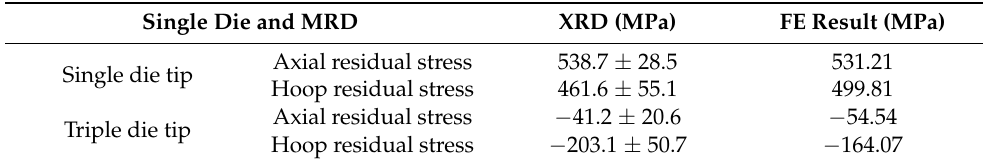
Table 7. Comparison of the measured and predicted residual stresses in single die and optimal MRD